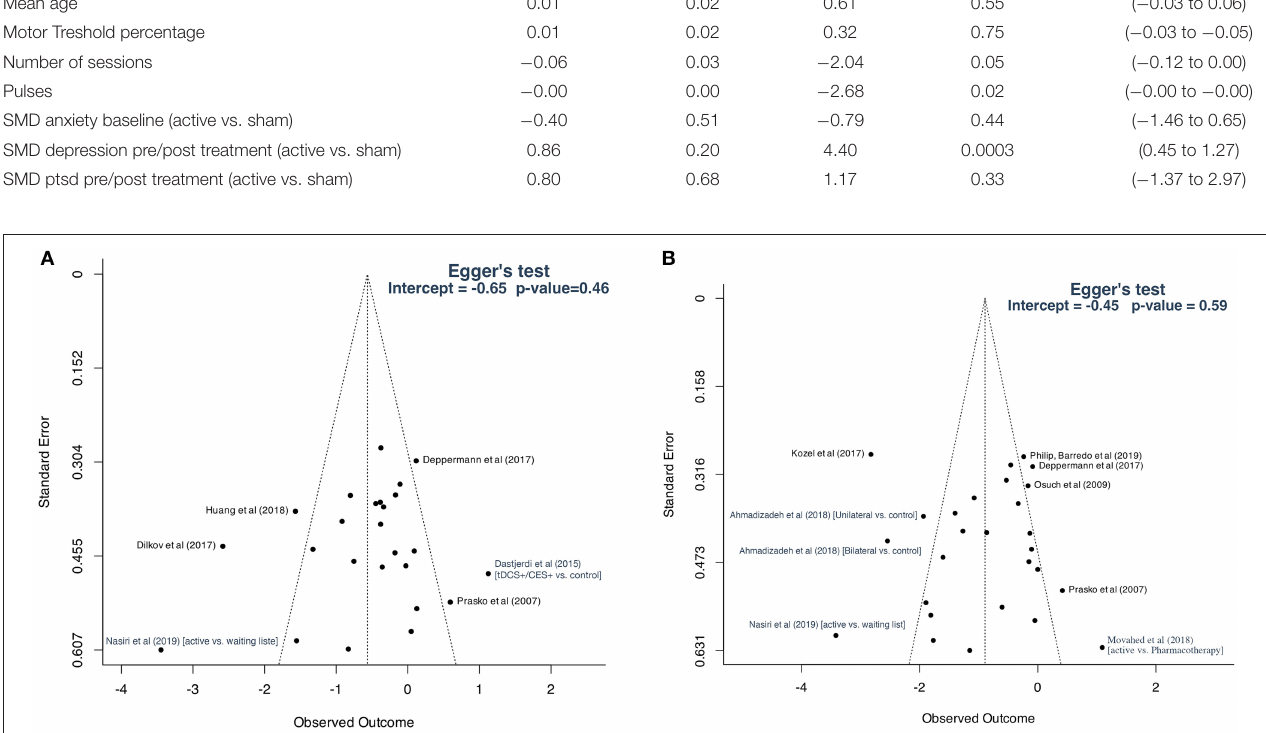
FIGURE 8 | Funnel plots: (A) studies included for primary outcome; (B) studies included for secondary analysis based on disorder-specific scales.